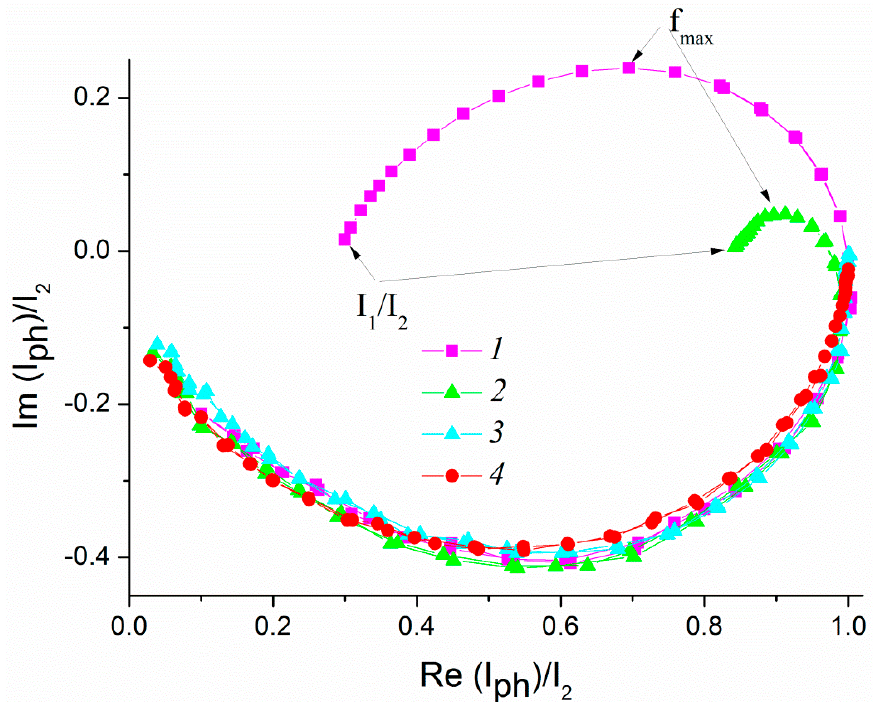
Figure 9. Normalized IMPS dependences for a Ti 4+ /Fe 2 O 3 /FTO film photoanode illuminated with monochromatic light 452 nm at the illumination power density 14 mW cm − 2 , obtained at a potential of 0.4 V in aqueous solutions of: (1) 0.1 M KOH; (2) 0.1 M KOH + 20% CH 3 OH); (3) 0.1 M KOH + 20% C 2 H 4 (OH) 2 ; (4) 0.1 M KOH + 20% C 3 H 5 (OH) 3 .